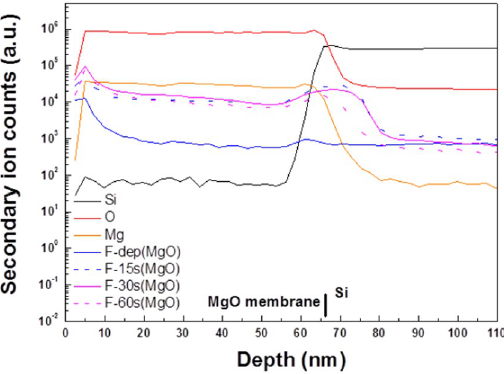
Figure 5. SIMS profiles of MgO sensing membrane/Si with CF 4 plasma treatment in various